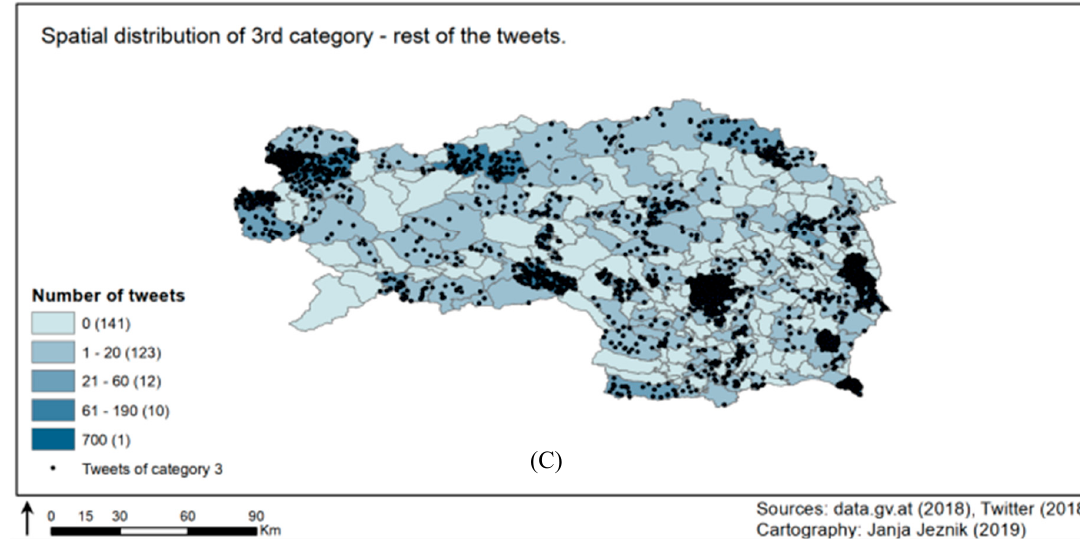
Figure 6. Spatial distribution of the tourism-related tweets according their subgroups. Map ( A ) depicts the number of tweets of category 1, having tourist related keywords. Map ( B ) shows the tweets of category 2—tweets that are of the form “I am at ... ”. Map ( C ) shows the rest of tourist related tweets—i.e., category 3.